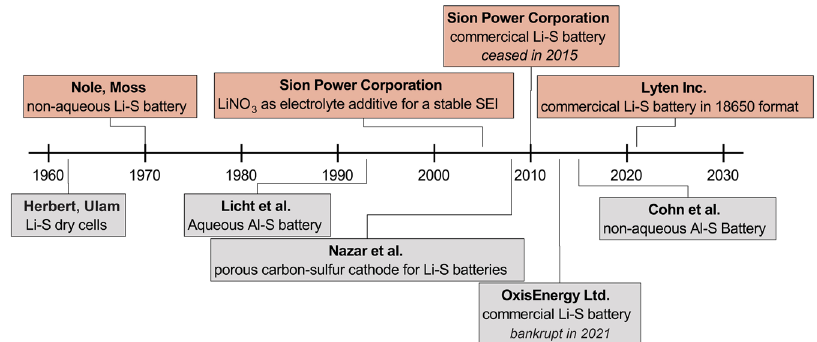
Fig. 2 Historical development of Li – S and Al – S batteries. Schematic representation of historical developments in the fi eld of Li – S and Al – S